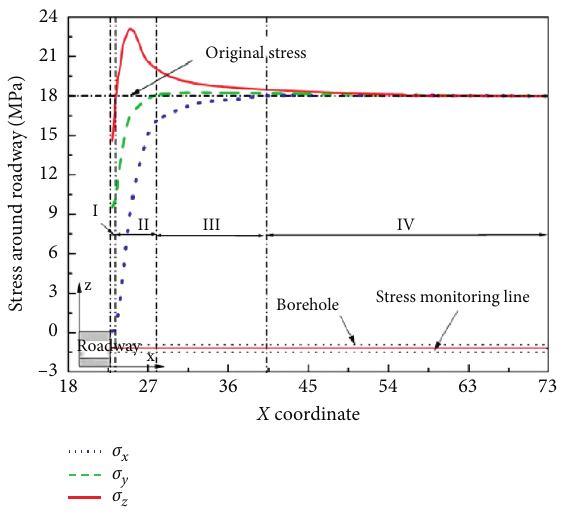
Figure 2: Distribution of stress field induced by roadway excavation.